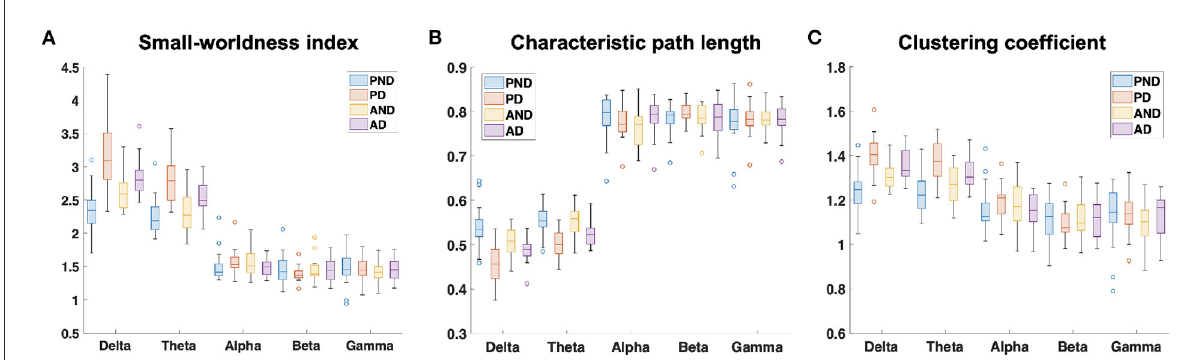
FIGURE3 Normalized average (A) small-worldness ( SW avg − norm ), (B) clustering coefficient ( C avg − norm ), and (C) characteristic path length ( L avg − norm ) indices over the five frequency bands. PND and PD refer to (passive, no delay) and (passive, delay) while AND and AD refer to (active, no delay) and (active, delay) conditions, respectively.